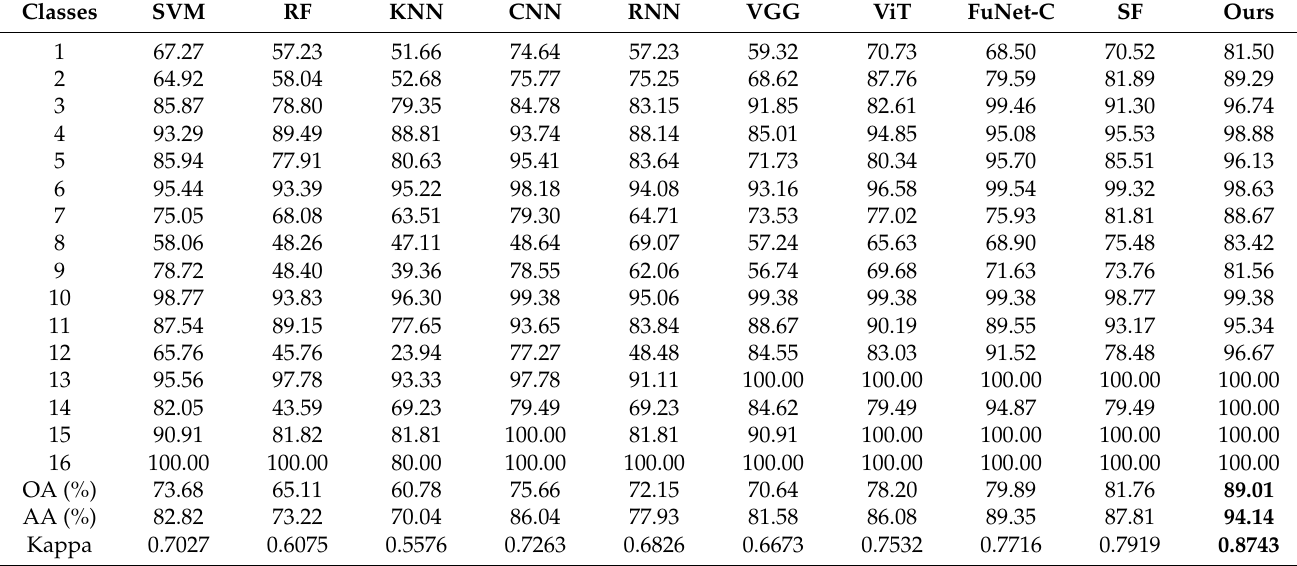
Table 6. OA, AA and kappa results of various algorithms on Indian Pines dataset.